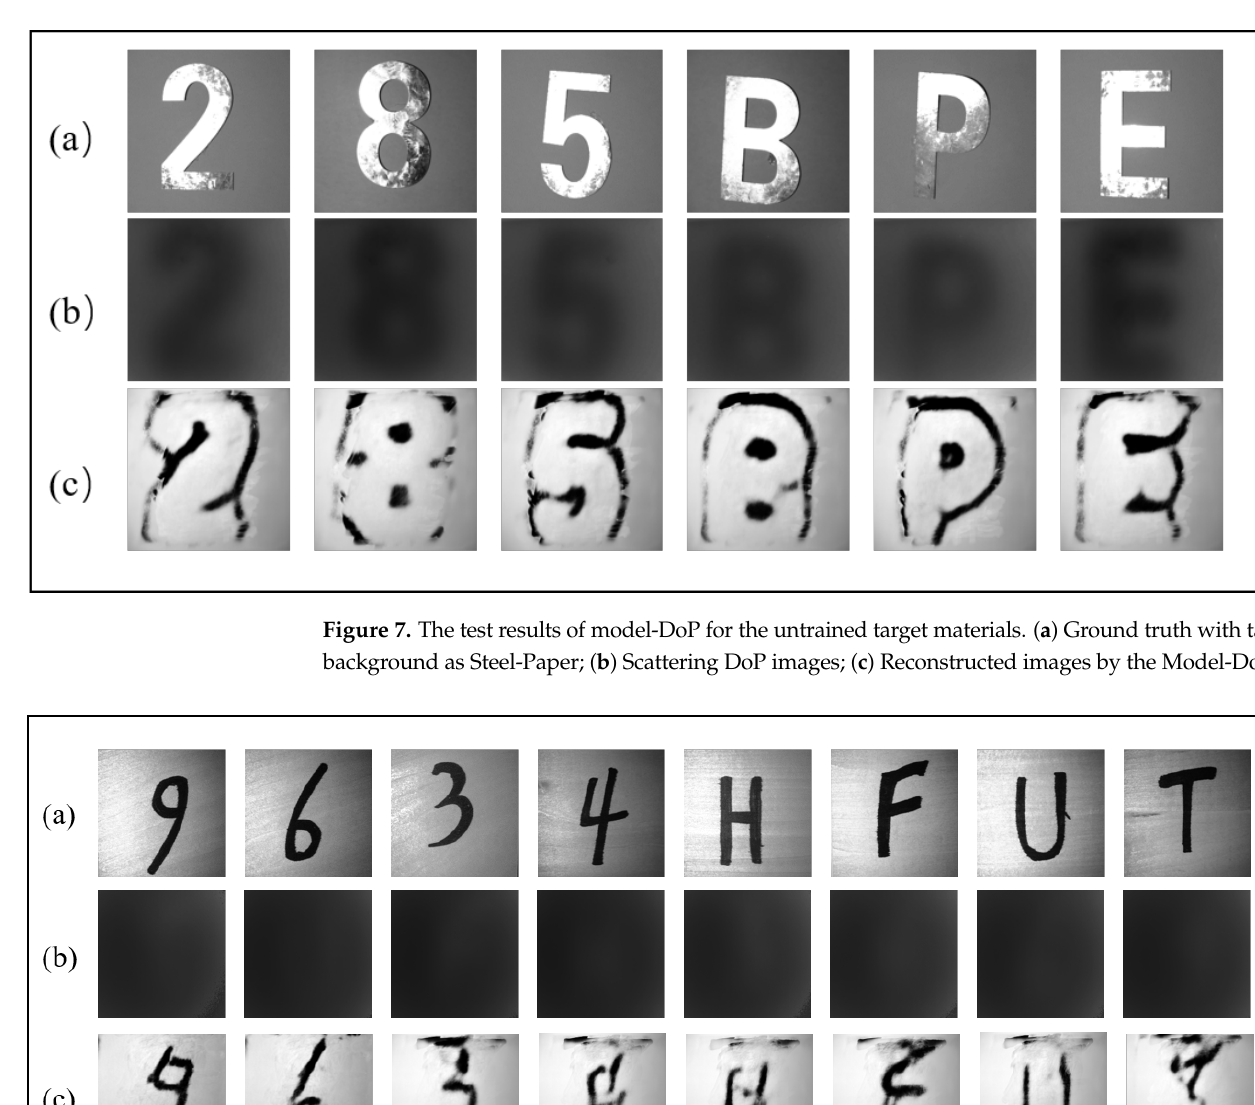
Figure 8. The test results of model-DoP for the untrained background materials. ( a ) Ground truth with target-background as Ink–Wood; ( b ) Scattering DoP images; ( c ) Images reconstructed by the Model-DoP.